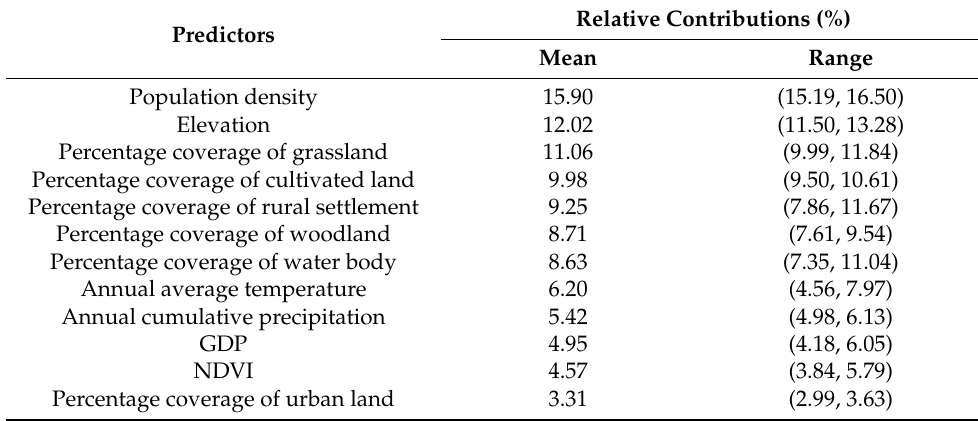
Table 2. Summary of relative contributions of each predictor for HFRS